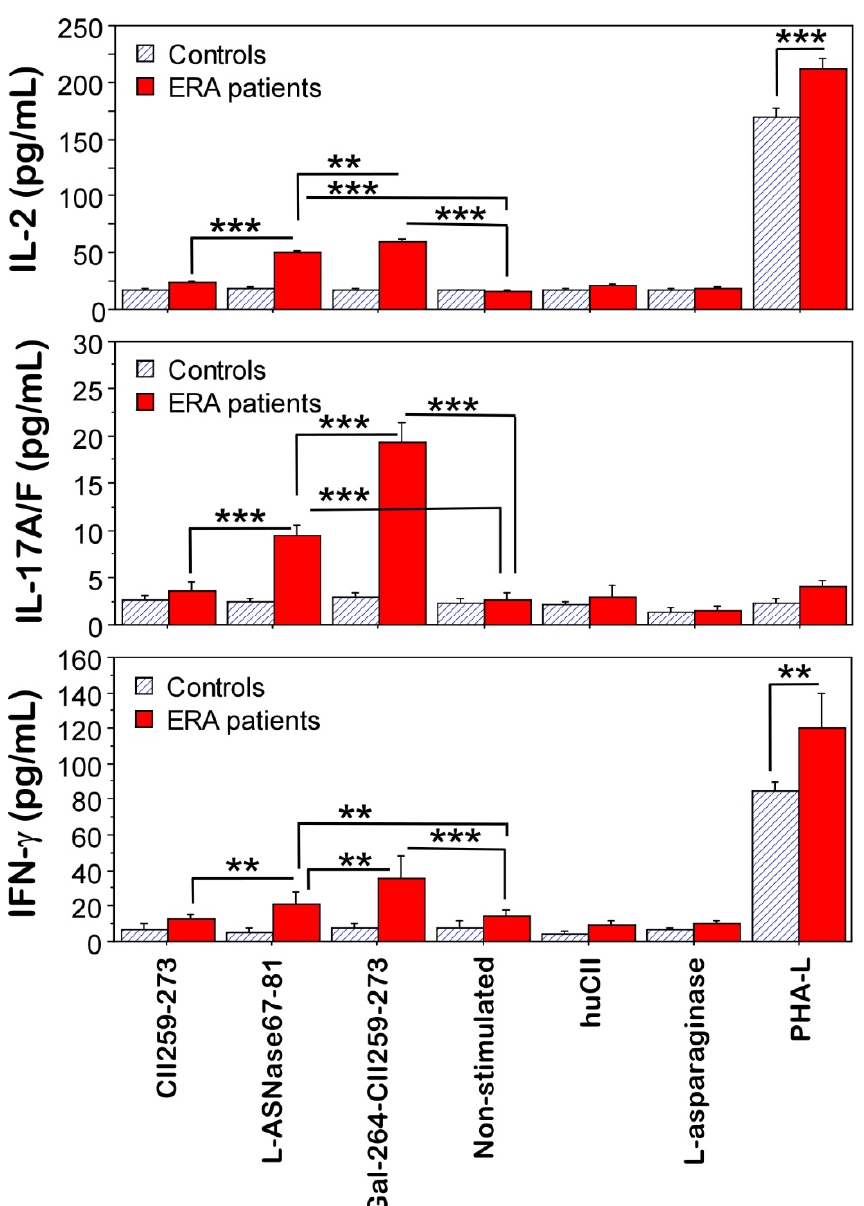
Figure 5. ELISA data for cytokine production by cultured leukocytes from ERA patients and healthy individuals (controls) after in vitro stimulation with different antigens for 96 h. Results are presented as means ± SE. ** p < 0.01, *** p < 0.001, as determined by Mann–Whitney U test.